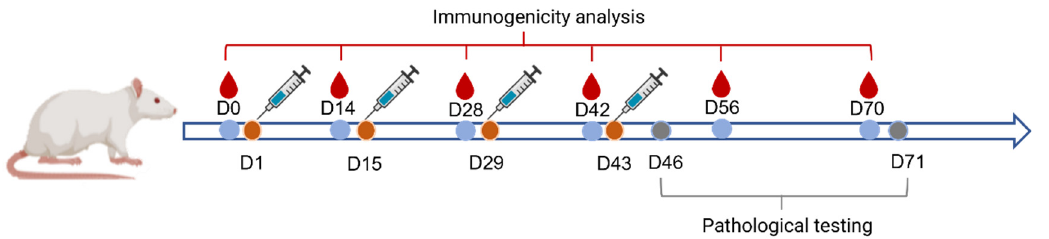
Figure 6. Frequency of administration. The vaccine was administered at D1, D15, D29, and D43. The blood was collected in D0, D14, D28, D42, D56, and D70 for immunogenicity analysis. The euthanasia was at D46 and